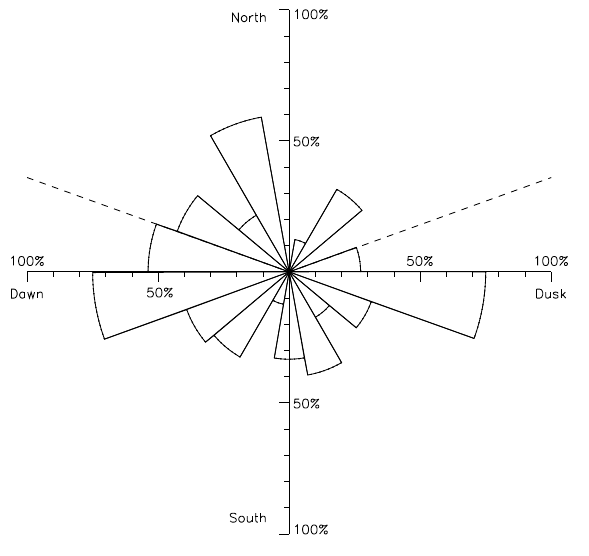
Fig. 3. The FTE “occurrence probability” (as defined by Kuo et al., 1995) for the survey carried out by Fear et al. (2005b) as a function of clock angle. The dashed line marks a clock angle of ± 70 ◦ .